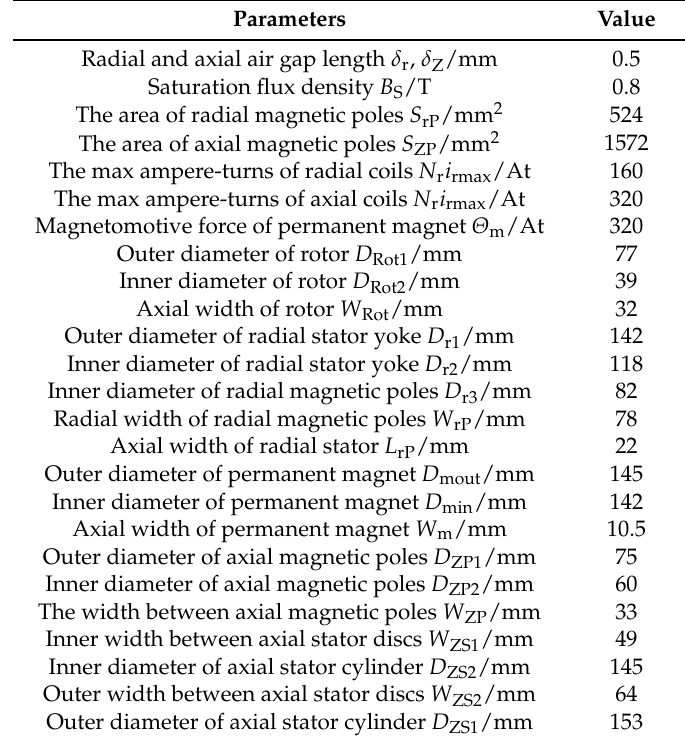
Table 2. Parameters of the six-pole radial-axial hybrid magnetic bearings (HMB).